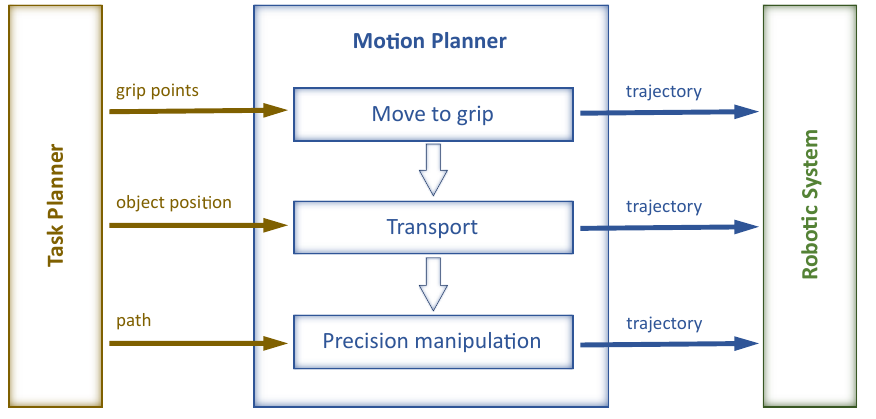
Figure 2. Basic idea of the task-motion-planning